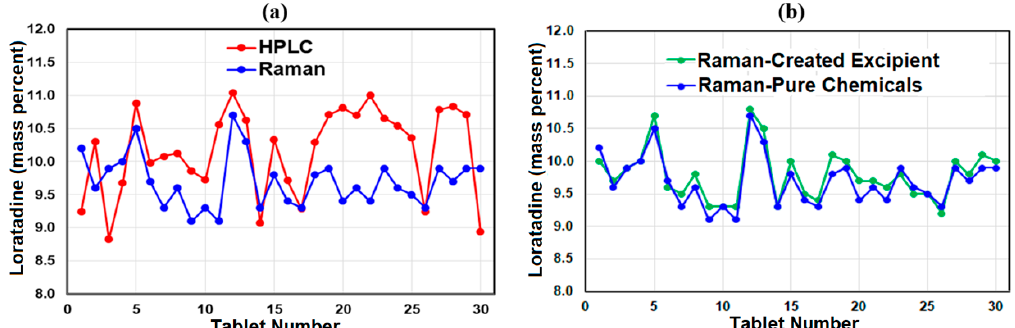
Figure 4. Plots of loratadine mass percentage as a function of tablet number for ( a ) HPLC and Raman using all excipients, and ( b ) Raman using all excipients and a created composite excipient.